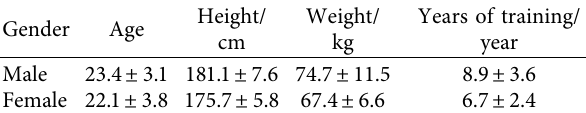
Table 1: Basic information of subjects.